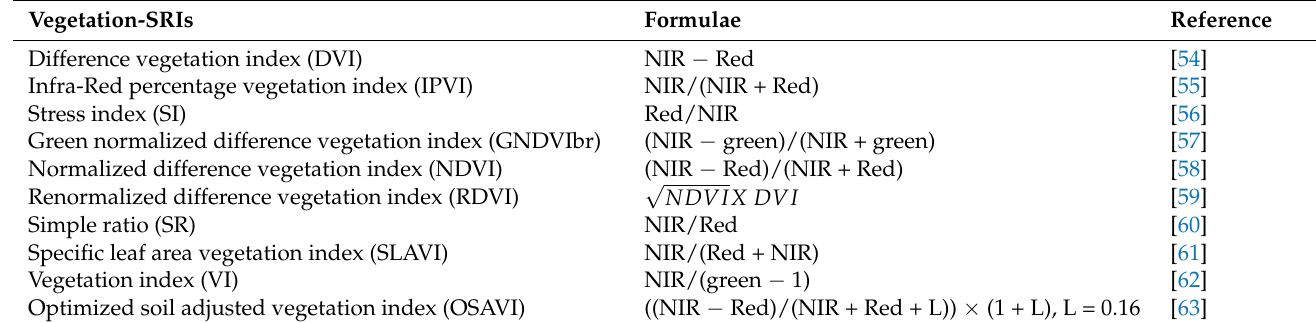
Table 2. Formulae of tested vegetation-SRIs and references collected from previous